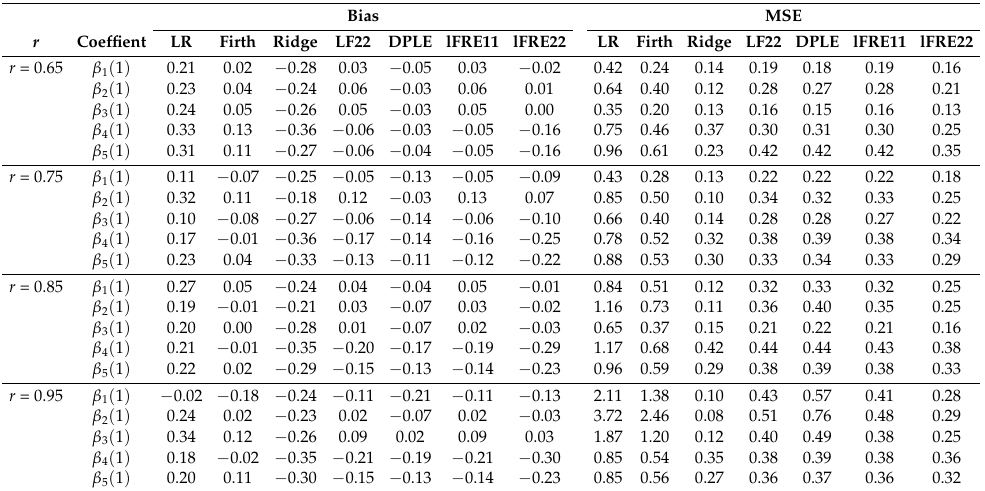
Table 4. Bias and MSE for all explanatory variables (omitting the intercept) for correlation